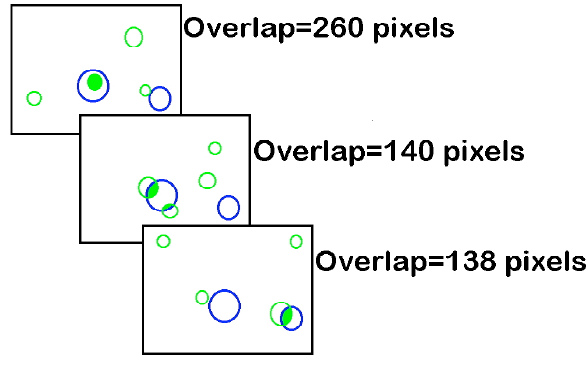
Figure 3 – A diagrammatic example of the calculation of the critical value of overlap, the 95-percentile point of the distribution of overlap values for aROIs with randomly replaced hROIs. Here three iterations of the minimum 1000 iterations are shown. The blue circles correspond to the areas that are predicted to be most fixated by the ʻ blue model ʼ , while the green circles represent the